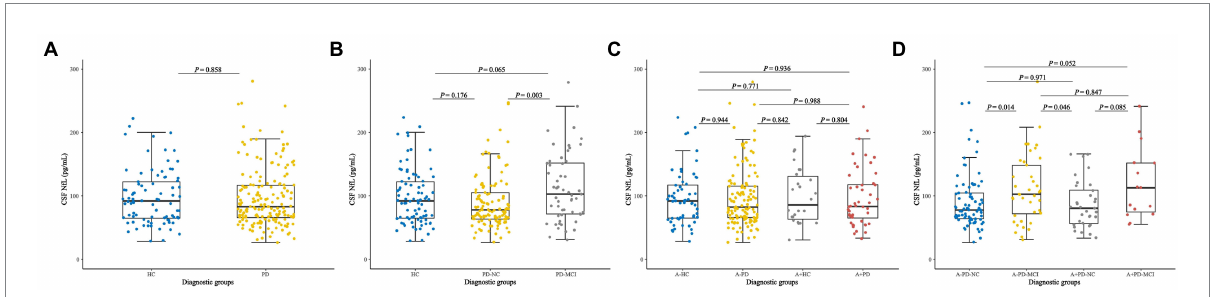
FIGURE 1 Baseline CSF NfL concentration of (A) Healthy controls and patients with de novo PD. (B) HC and de novo PD patients with different cognitive status. (C) HC and de novo PD patients in different amyloid status. (D) HC and de novo PD patients with different cognitive status in different amyloid status. CSF, cerebrospinal fluid; NfL, neurofilament light; HC, Healthy controls; PD, Parkinson’s disease; PD-NC, PD patients with normal cognition; PD-MCI, PD patients with mild cognitive impairment; A,